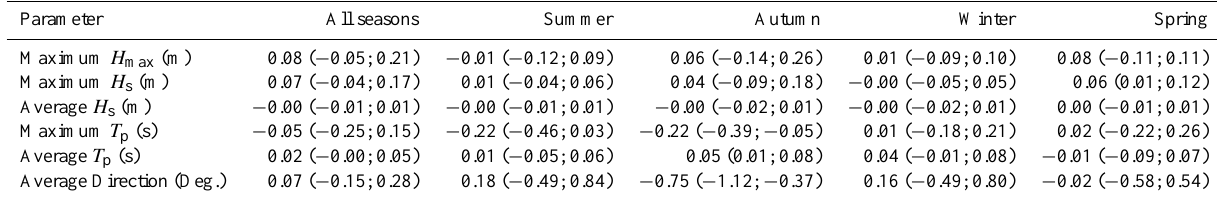
Table 4. Annual rate of change of Richards Bay’s wave parameters. The bracketed values are the 95% confidence intervals.